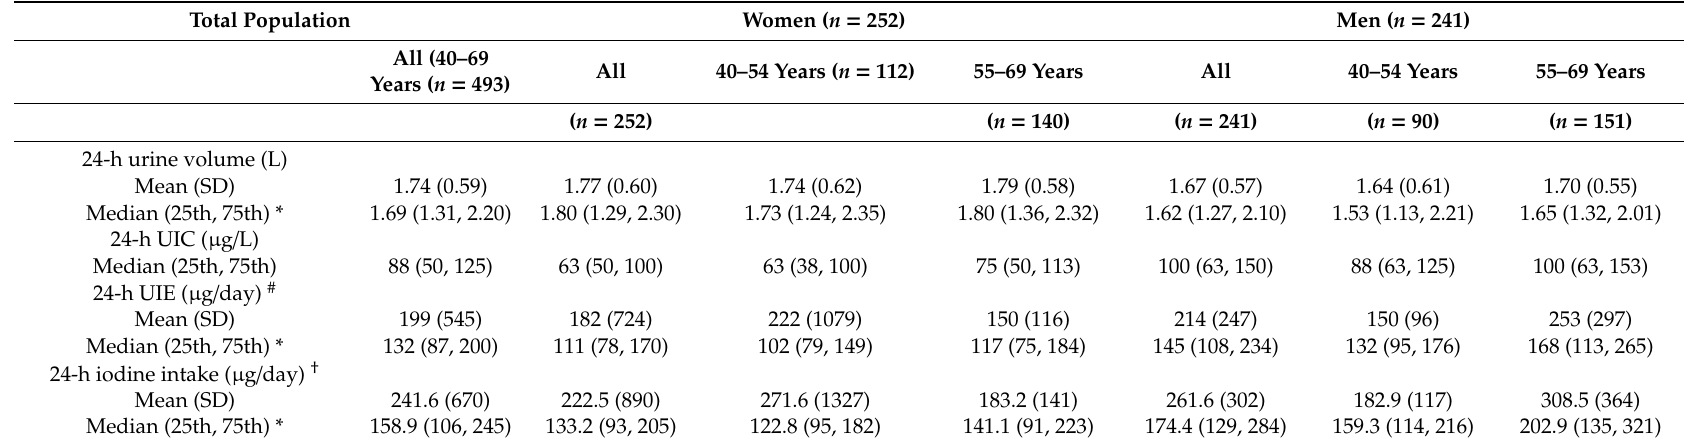
Table 2. Median and interquartile ranges of 24-h urine volume, 24-h urine iodine concentration (UIC), 24-h iodine excretion (UIE), and 24-h iodine intake by sex